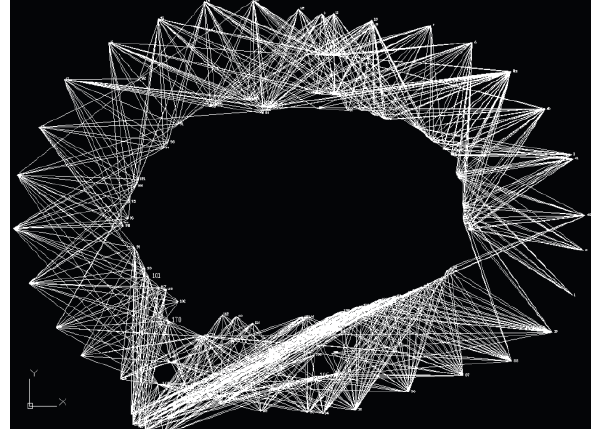
Figure 19. The 2018 control network of the Citadel, 45 panos Figures 21 and 22 of the throne hall in the Citadel, have been produced from the same shot of Panono® camera.